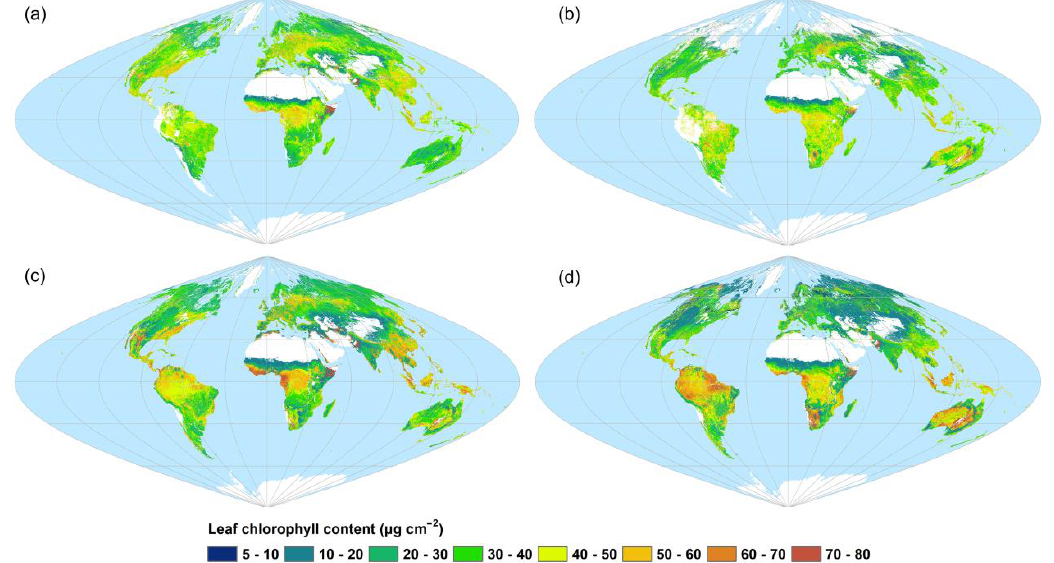
Figure 8. Spatial distribution of the mean LCC using MERIS and OLCI data in the different seasons: ( a ) and ( b ) are the mean LCC map using MERIS data in 2009 during the growing and non-growing season for the northern hemisphere, respectively; ( c ) and ( d ) are the mean LCC map using OLCI in 2019 during the growing and non-growing season for the northern hemisphere, respectively.